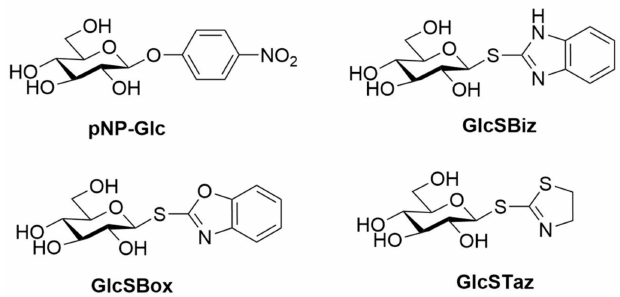
Figure 2. Substrates used in this